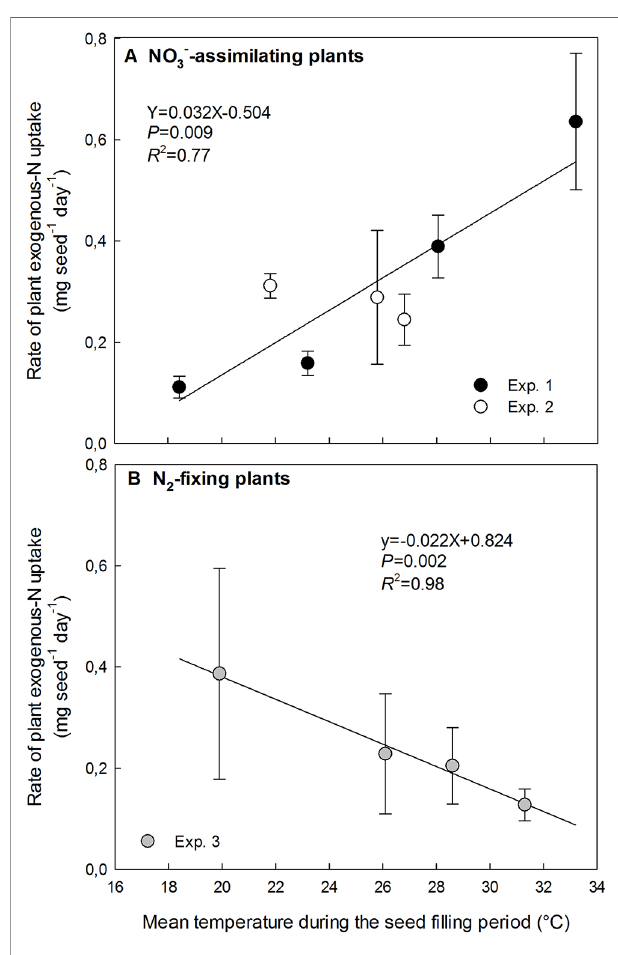
FIGURE 4 | Opposite responses to temperature increase of exogenous-N uptake rate in plants during the seed- fi lling period for NO 3 − -assimilating plants (A) and N 2 - fi xing plants (B) . The vertical bars represent SE. The data were fi tted with a linear